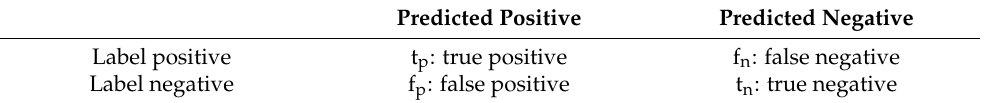
Table 3. Confusion